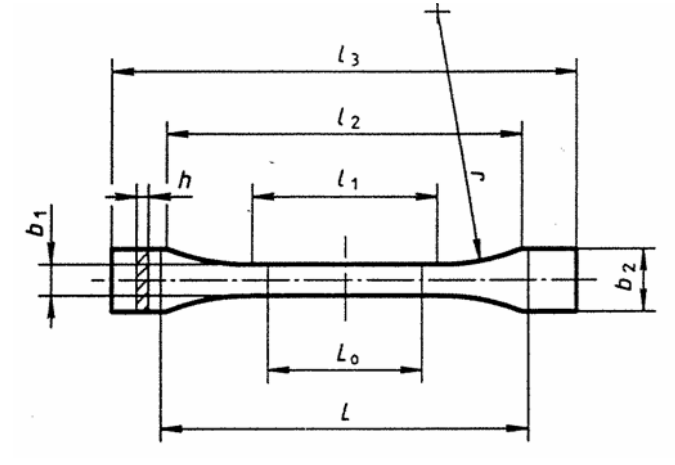
Figure 1. Sample type 1BA for strength test [21].